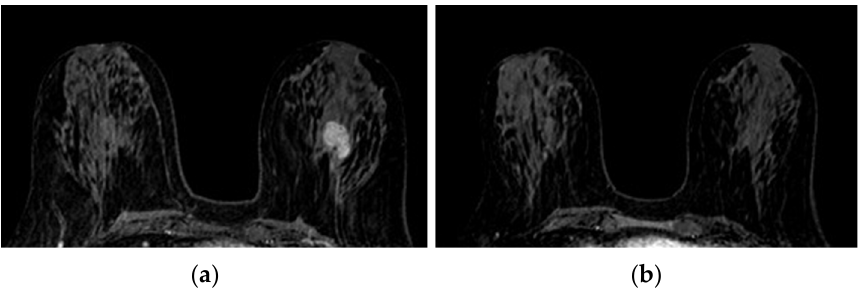
Figure 5. Complete pathological response (pCR): 2,5 cm deep retroareolar tumor on the left breast in the pre-treatment baseline survey (( a ) triple negative) no longer visible at the end of the therapy cycles ( b ). Reduction of a BPE class (moderate to mild) is observed.